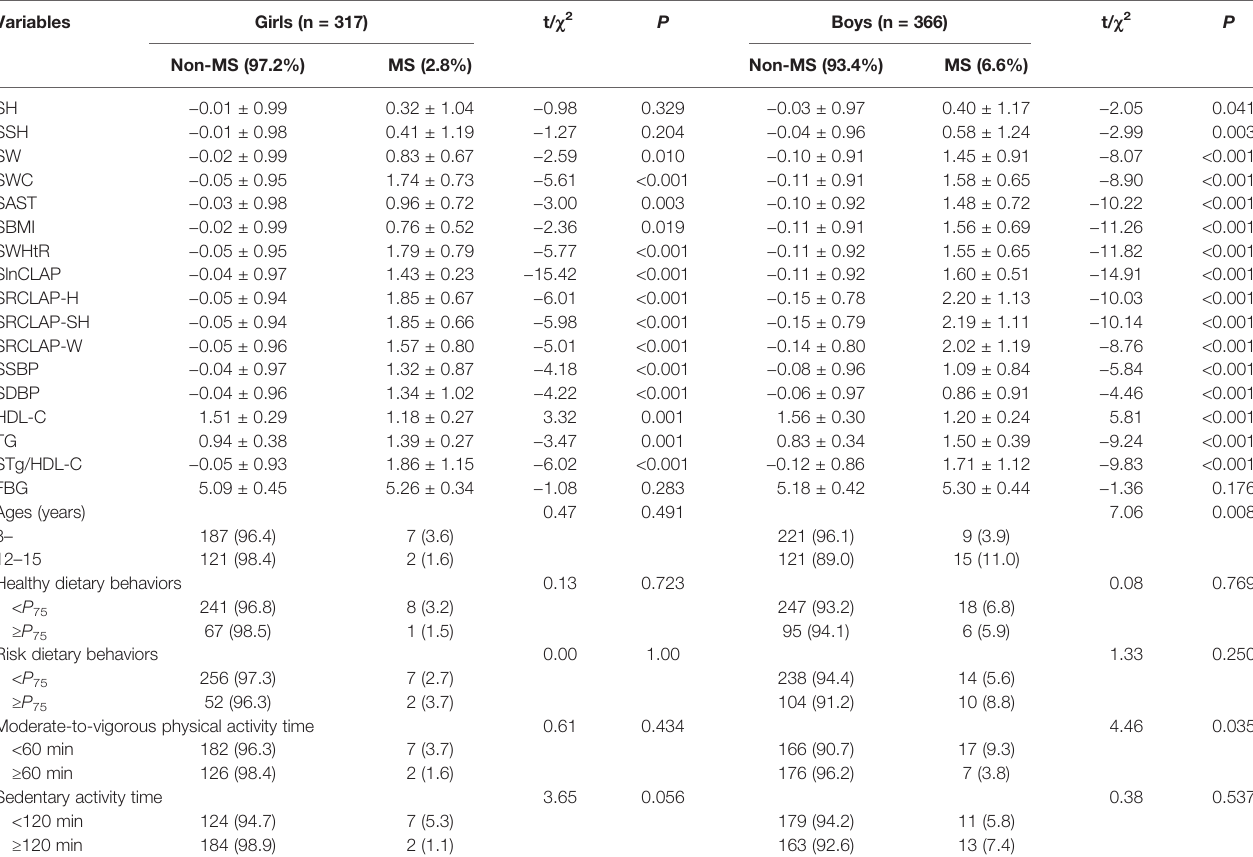
TABLE 1 | The comparison of anthropometric characteristics, dietary behaviors, physical activities, CLAP, and RCLAP among children with Non-MS and